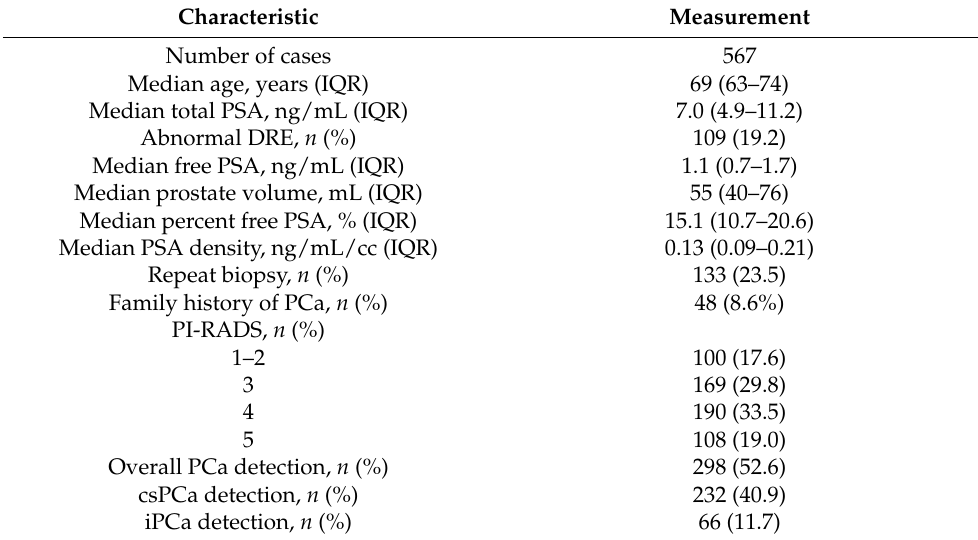
Table 1. Characteristics of the study cohort.